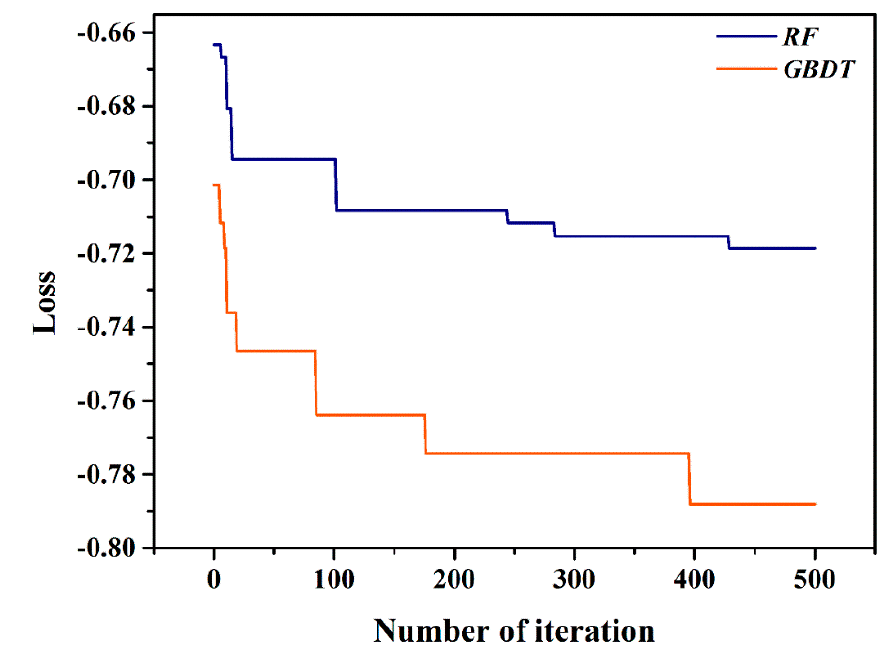
Figure 5. The loss in the iterative process of Bayesian optimization.